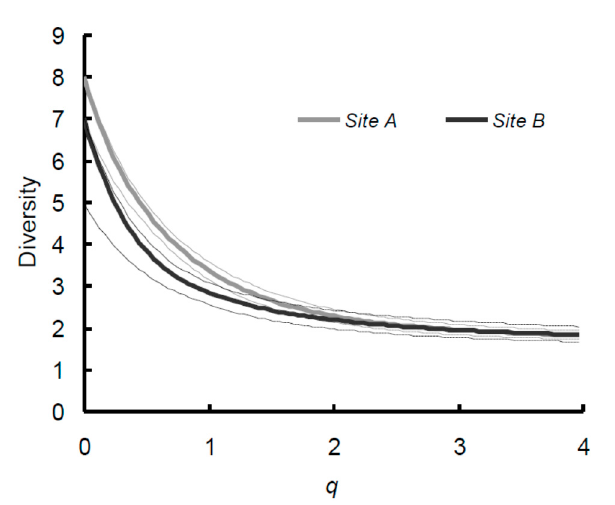
Figure 8. Diversity profile curves for the tenebrionid beetles collected in two sites (A and B) in the Ulan Buh Desert (Gobi Desert, Inner Mongolia, China): Site A (gray) and Site B (black). Dotted lines are 95% confidence intervals based on 2000 replicates.